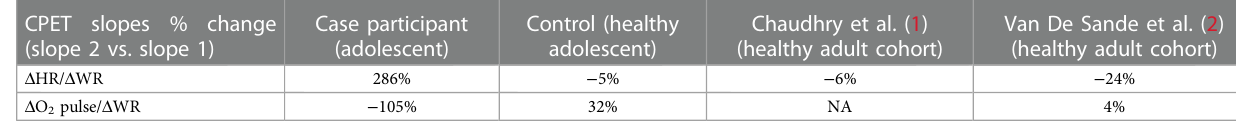
TABLE 2 CPET slope changes: case participant vs. healthy control and published